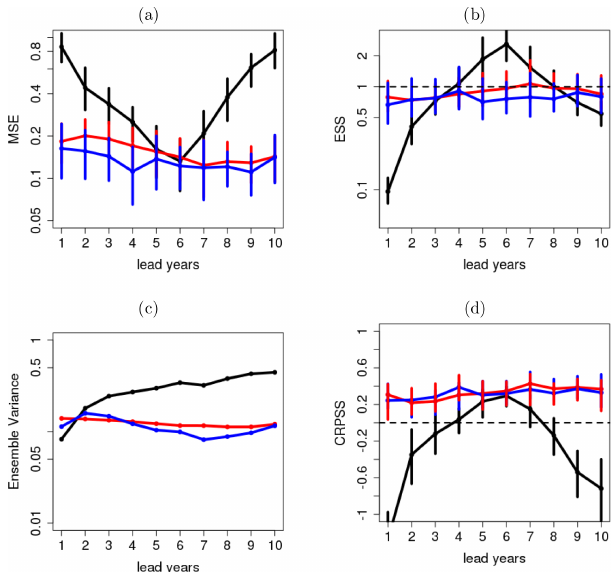
Figure 13. (a) MSE, (b) reliability, (c) ensemble variance and (d) CRPSS of surface temperature over the North Atlantic without any correction (black line), after recalibration with DeFoReSt (blue line) and boosted recalibration (red line). The CRPSS for the raw forecasts (black line) for lead year 1 is smaller than − 1 and there- fore not shown. The vertical bars show the 95% confidence interval due to 1000-wise